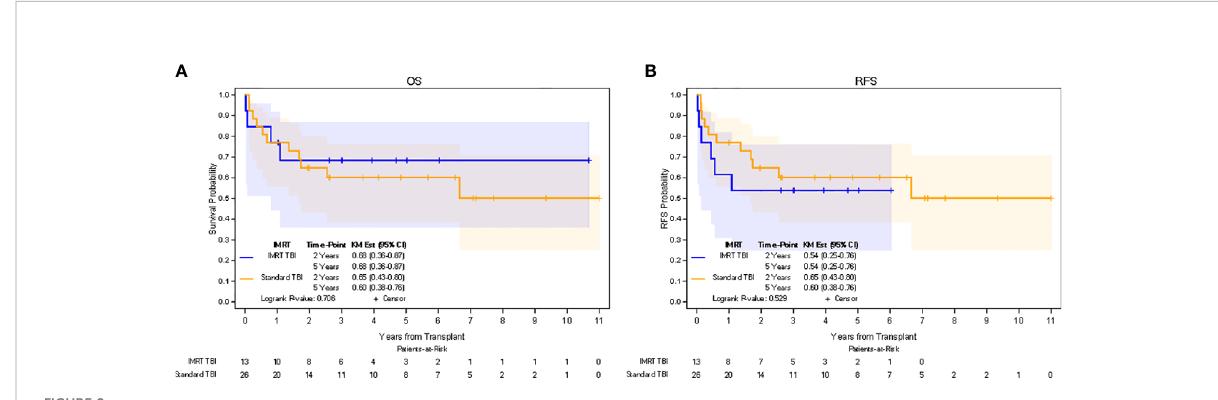
FIGURE 2 Kaplan Meier estimates of overall survival (A) and recurrence-free survival (B)